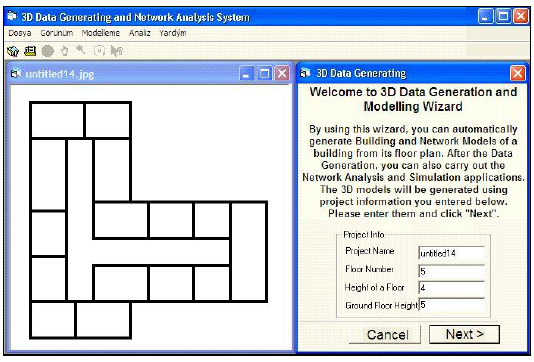
Figure 6. 3D Network Model Construction User Interface